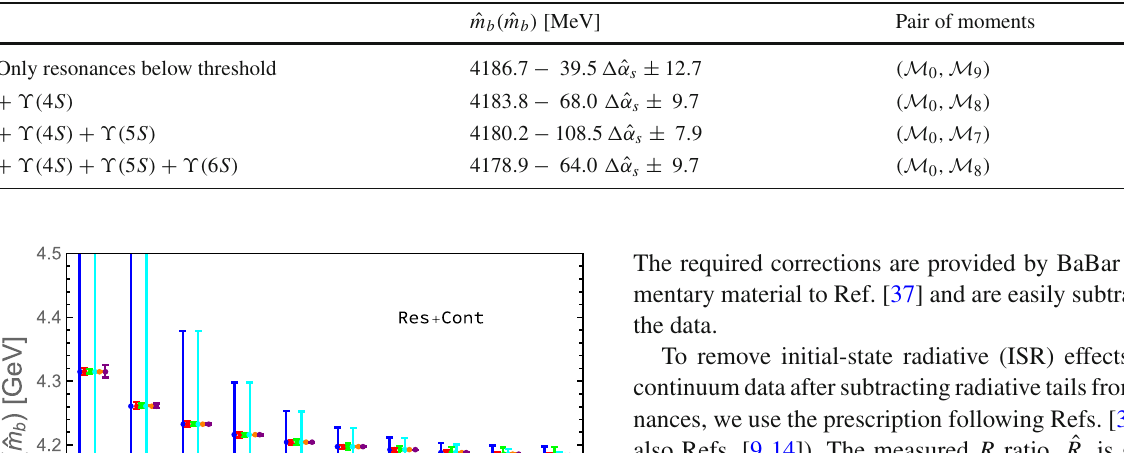
Table 4 Values and uncertainties of the bottom quark mass when adding various resonances on top of the continuum ansatz . Only the values with the smallest uncertainty and the corresponding pair of moments from which it is obtained are shown in each case